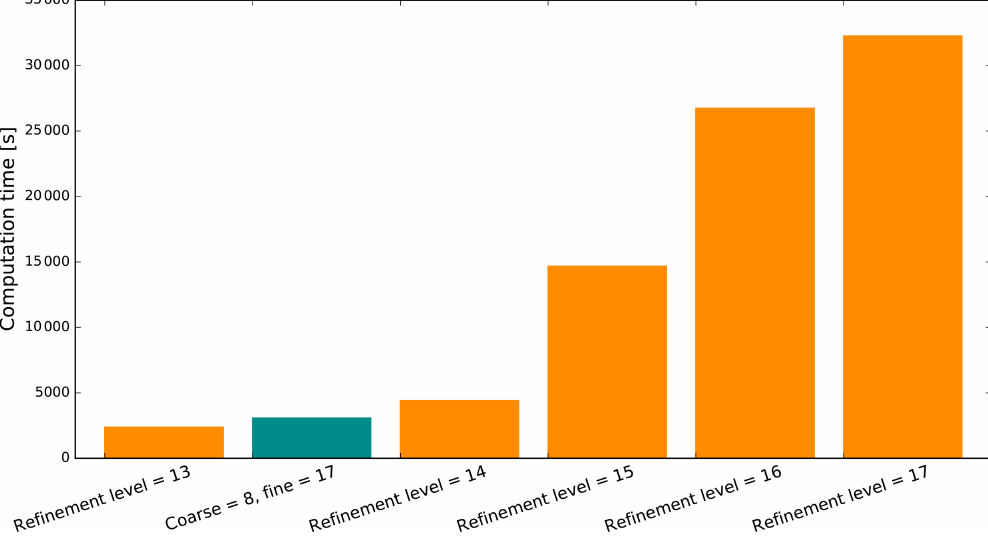
Figure 12. Comparison of the computation times of simulations on a uniform mesh with refinement levels of 13, 14, 15, 16 and 17 and on the adaptive mesh with a coarse-mesh level of 8 and a fine-mesh level of 17. Calculations were carried out on a Lenovo ThinkPad with an i3-2310M processor and 8GB of main